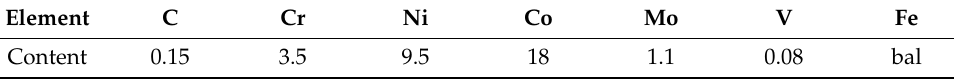
Table 1. Elemental content (mass fraction) of the C61 steel.